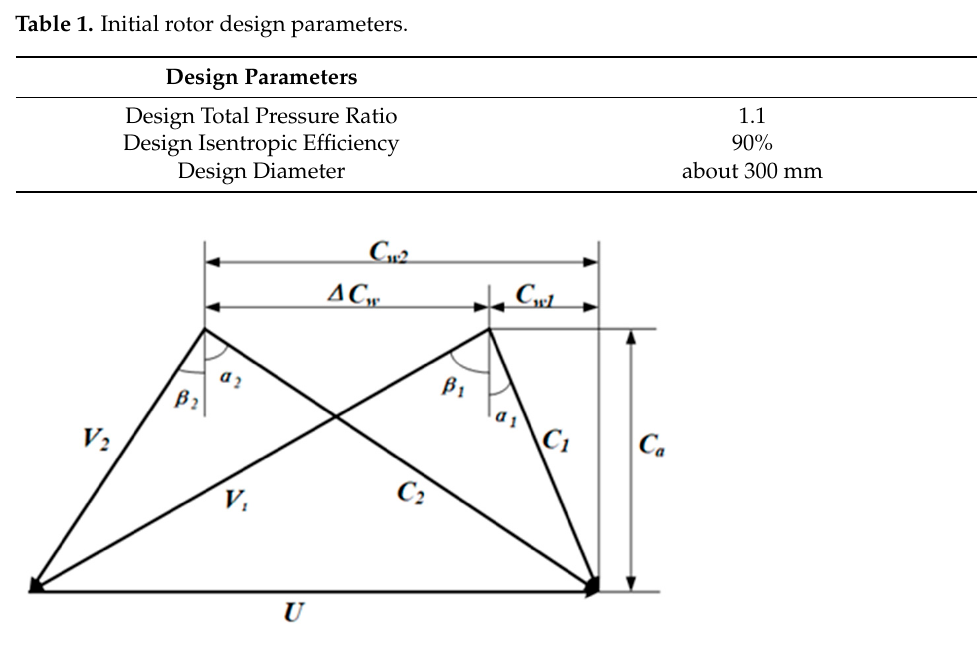
Figure 1. Velocity triangle.